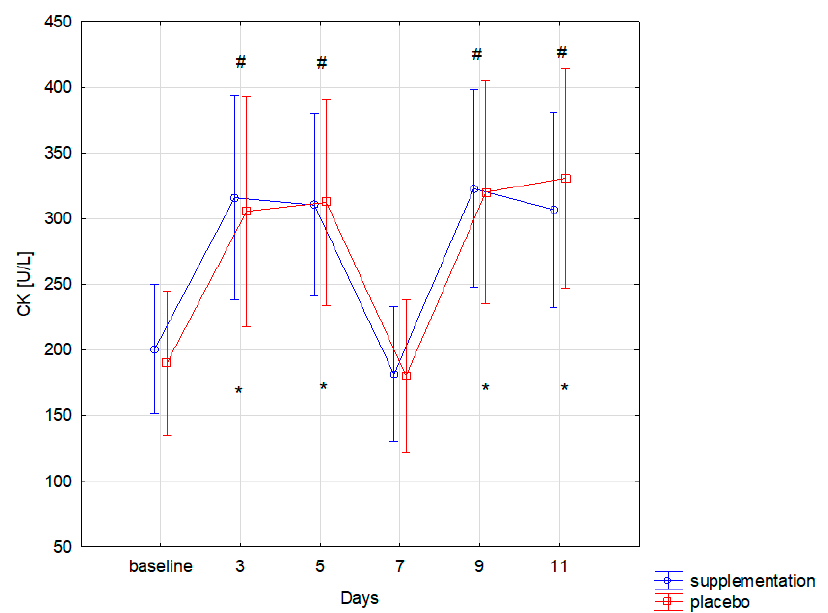
Figure 2. Creatine kinase (CK) concentration in subsequent days in supplements (SUP) and placebo (PL) groups (* significant change ( p < 0.05) to baseline in PL group; # significant change ( p < 0.05) to baseline in SUP group).